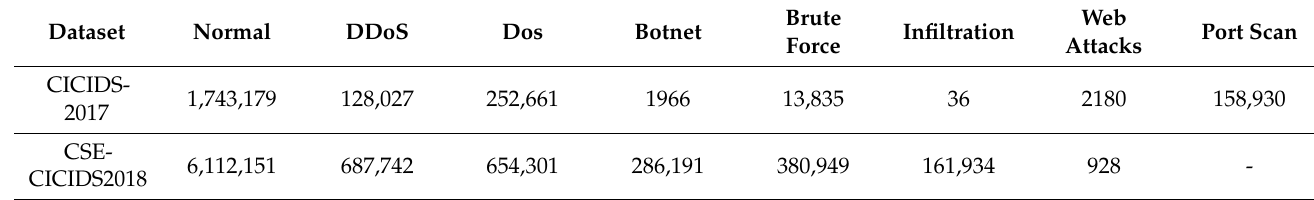
Table 3. Comparison of the CSE-CIC 2018 ID dataset with